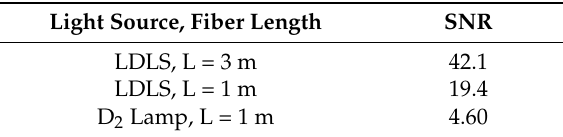
Figure 4. Absorption spectra of NO gases (at 1 ppm) measured by three different setups: (i) LDLS light source with 3-m-long fiber; (ii) LDLS with 1-m-long fiber; and (iii) deuterium lamp source with 1-m-long fiber. Table 1. Measured SNRs for three combinations of light source and fiber length.